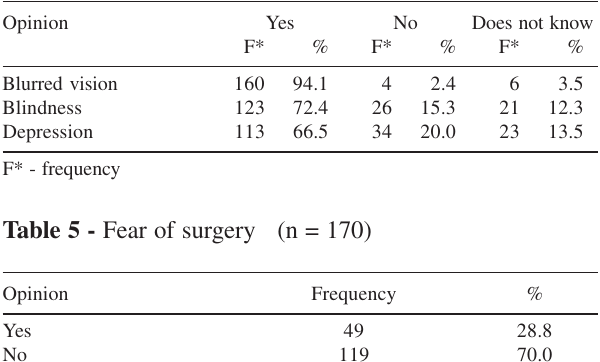
Table 2 - Conceptions about cataract (associated answers) n = 170